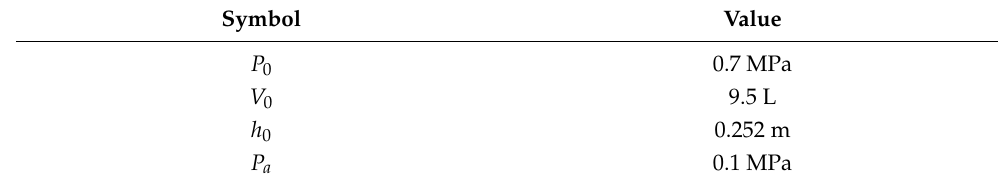
Table 2. Parameter values of the air spring.